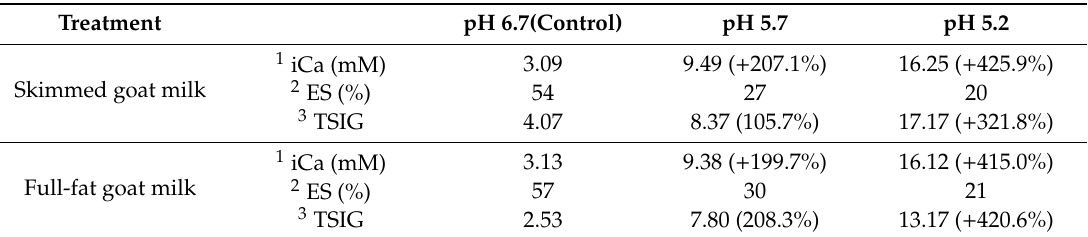
Table 3. E ff ect of pH on the ionic calcium concentrations, ethanol stability, and TSIG values of skimmed and full-fat goat